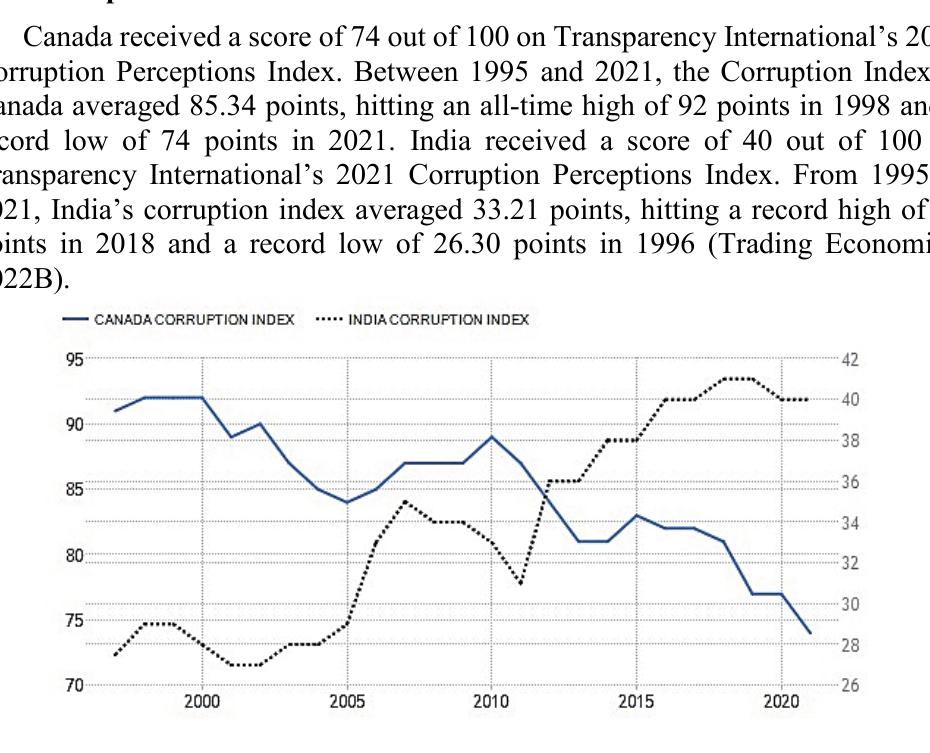
Fig. 3. Corruption index: India vs Canada. Source: (Trading Economics,